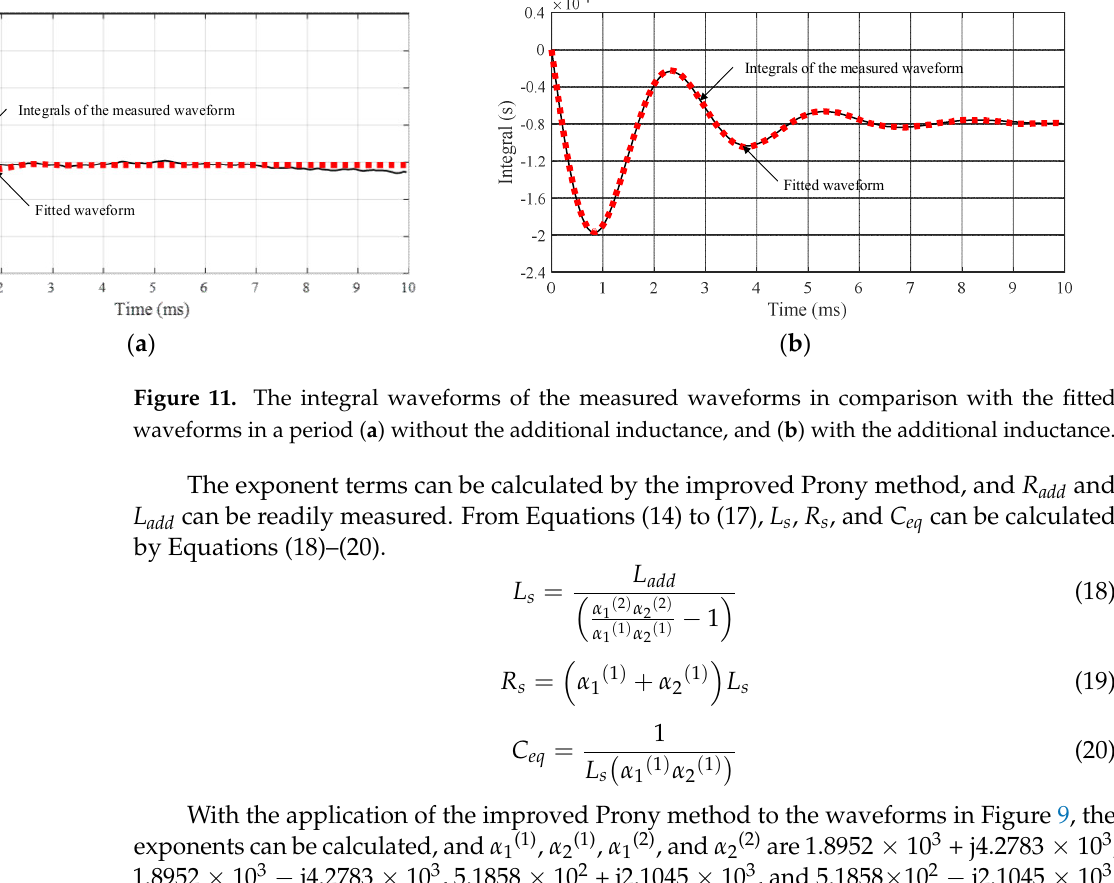
1.8952 × 10 3 − j4.2783 × 10 3 , 5.1858 × 10 2 + j2.1045 × 10 3 , and 5.1858 × 10 2 − j2.1045 × 10 3 , respectively. With the known circuit parameters (i.e., R add of 34.56 k Ω and L add of either 0 or 132.92 H on the HV side), and by transferring all impedance to the HV side, it can be determined by Equations (18)–(20), and L s , R s , and C eq are 36.310 H, 137.63 k Ω , and 1.257 nF, respectively. The fitting curve using the determined parameters was in good agreement with the measured waveforms, as also shown in Figure